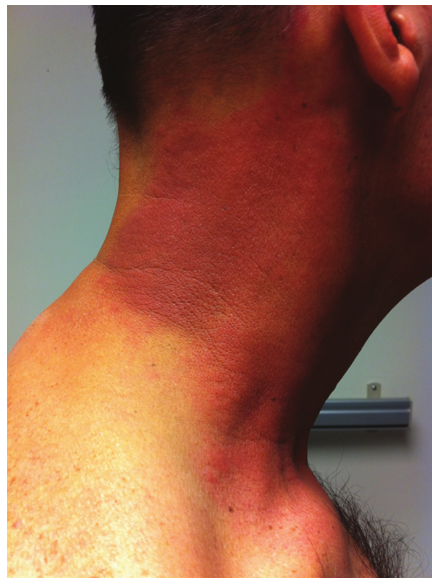
Figure 1: Lateral aspect of patient’s right neck demonstrating af- fected area.